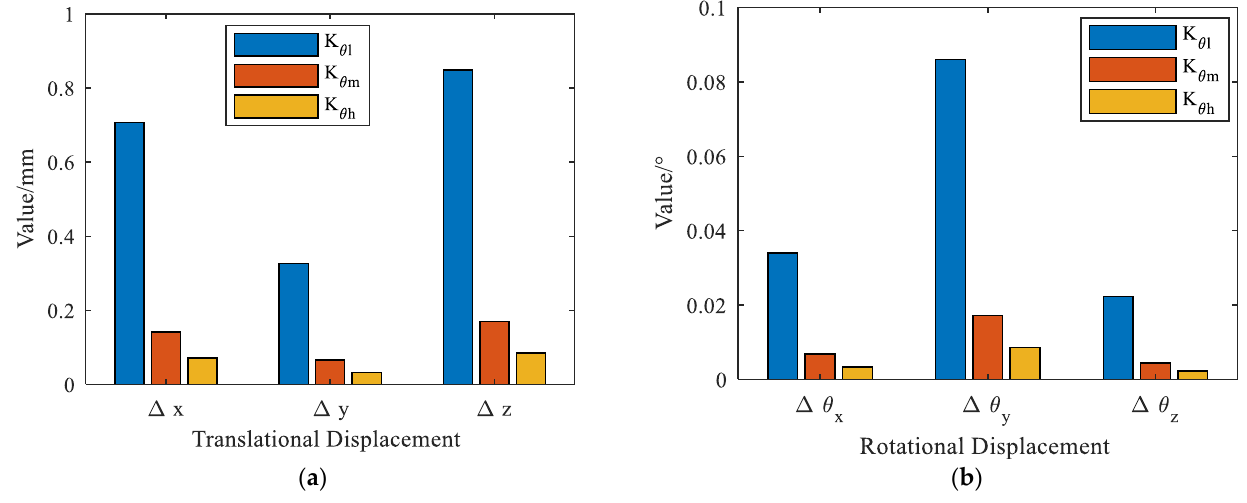
Figure 4. The generalized displacements of the end effector of the humanoid manipulator with different joint space stiffness. ( a ) Translational displacements of the end effector; ( b ) Rotational displacements of the end effector.